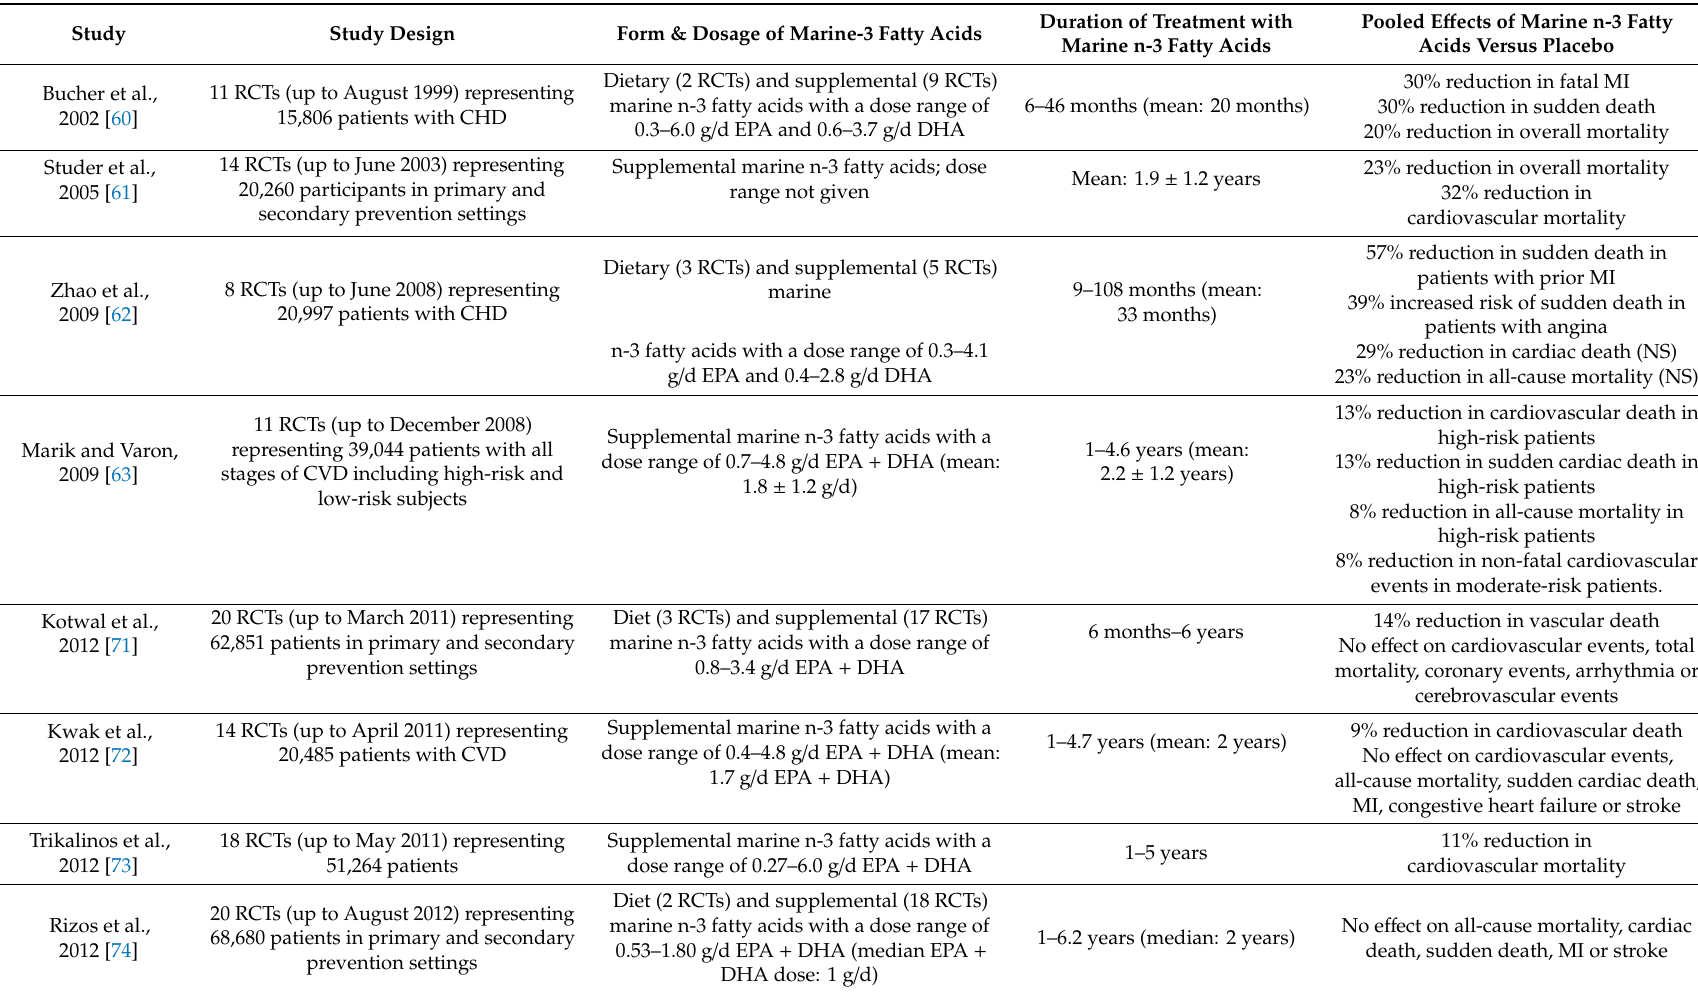
Table 3. Meta-analyses published up to 2018 of RCTs investigating the e ff ect of marine n-3 fatty acids on cardiovascular